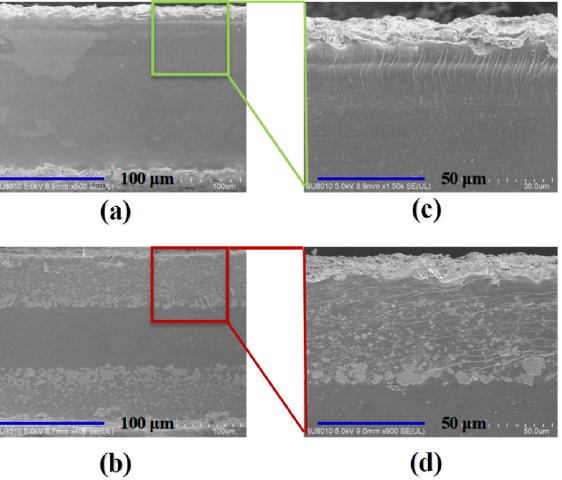
Figure 5. Cross ‐ section SEM images of the IPMCs. ( a ) Pd ‐ IPMC based on pure Nafion matrix membrane; ( b ) Pd ‐ IPMC based on SCNT/Nafion composite matrix membrane, ( c , d ) magnification membrane; ( b ) Pd-IPMC based on SCNT/Nafion composite matrix membrane, ( c , d ) magnification level of electrode and interface layer. level of electrode and interface